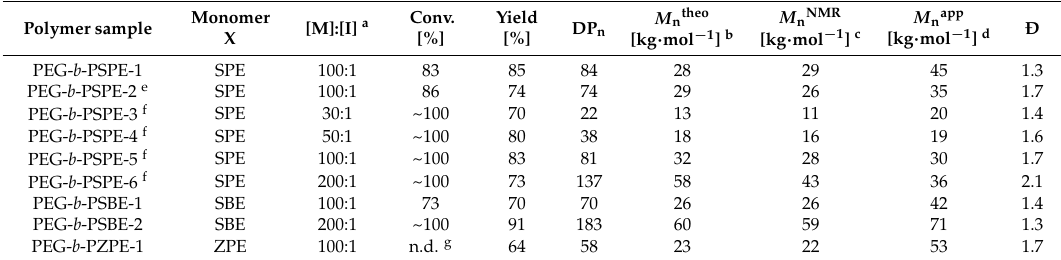
Table 1. Analytical data of block copolymers mPEG 114 - b -PX n obtained by ATRP in solvent TFE using mPEG-Br as macroinitiator, CuBr/2,2-bipyridyl as catalyst system at 60 ◦ C/24 h, and reagents engaged. Polymer